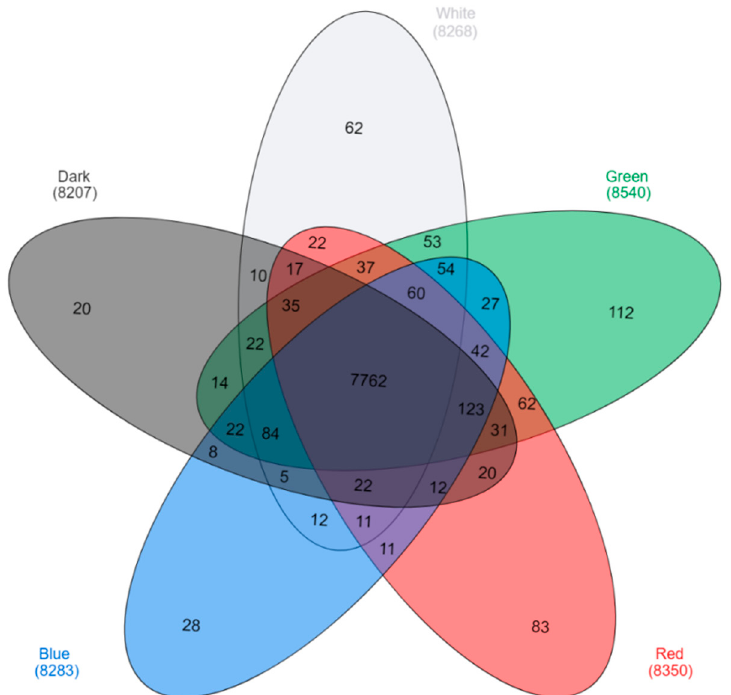
Figure 1. Venn diagram [22] demonstrating the number of expressed genes obtained for the tested samples. Transcripts found uniquely during C. unicolor growth in white light (light grey), green light (green), red light (red), blue light (blue), and dark (dark grey) are marked. The numbers of transcripts common for two, three, four, and all five tested growth conditions are indicated.